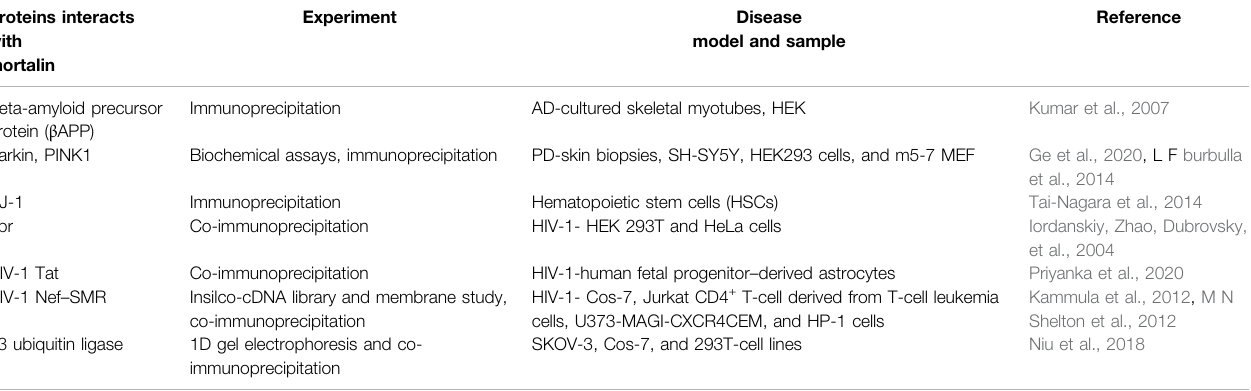
TABLE 2 | Schematic representation of protein – protein interaction between mortalin and other proteins under different conditions. Proteins interacts with